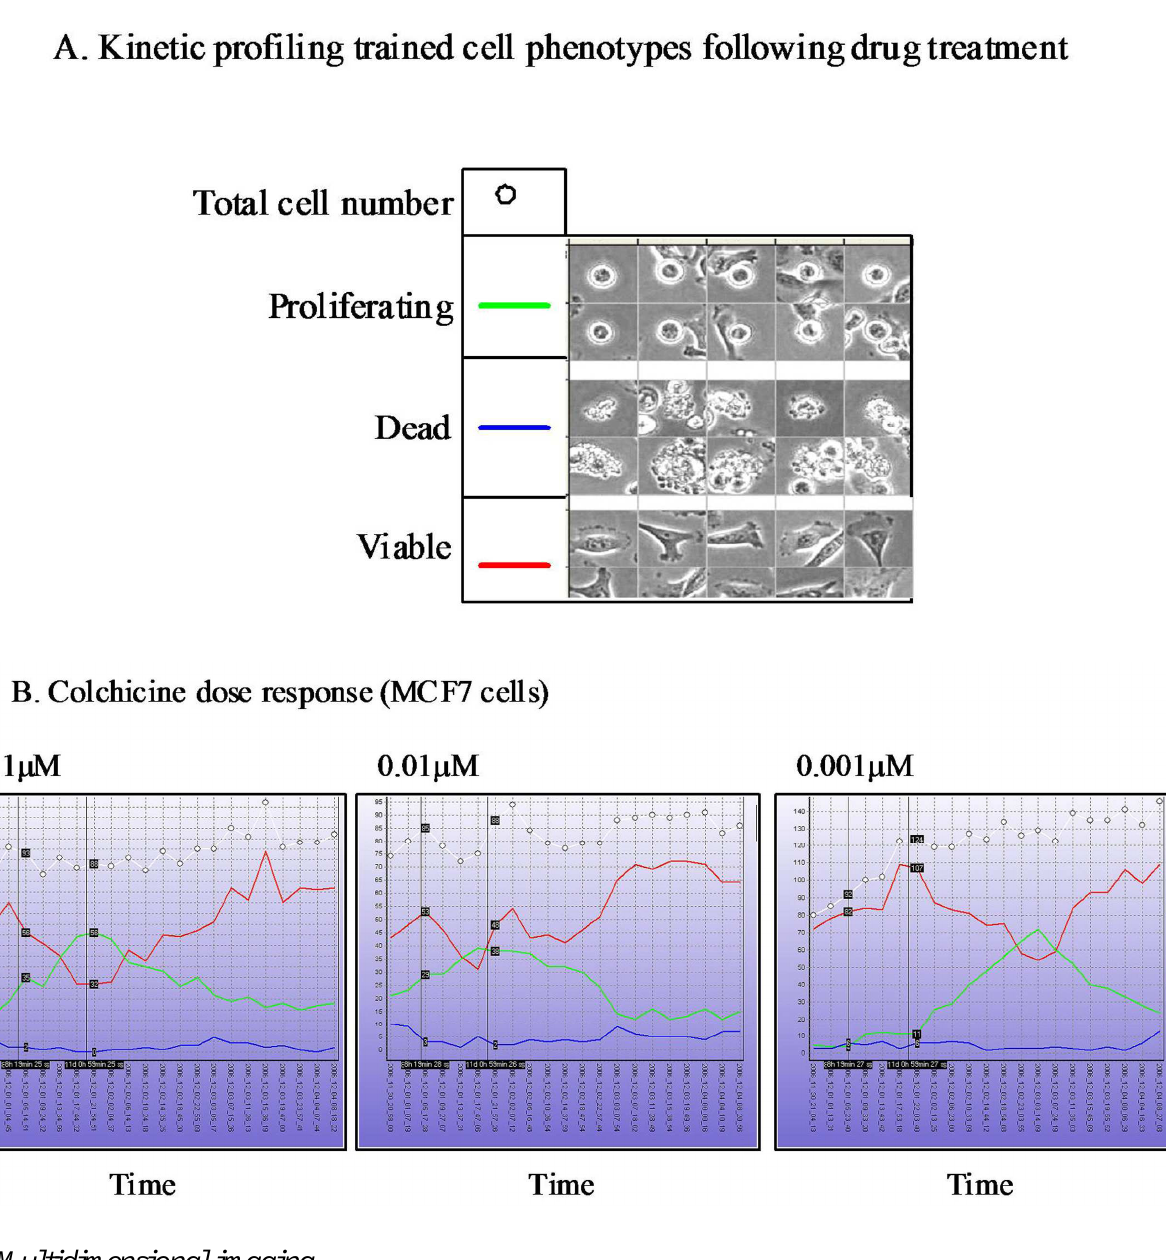
Figure 3. Cell-IQ TM Kinetic phenotypic profiling of drug response. ( A ) Machine learning based training of cellular phenotypes from phase contrast images. ( B ) Kinetic monitoring of the proportion of each phenotypic class and total cell number (within a single field of view) following treatment with different concentrations of colchicine. Data presented